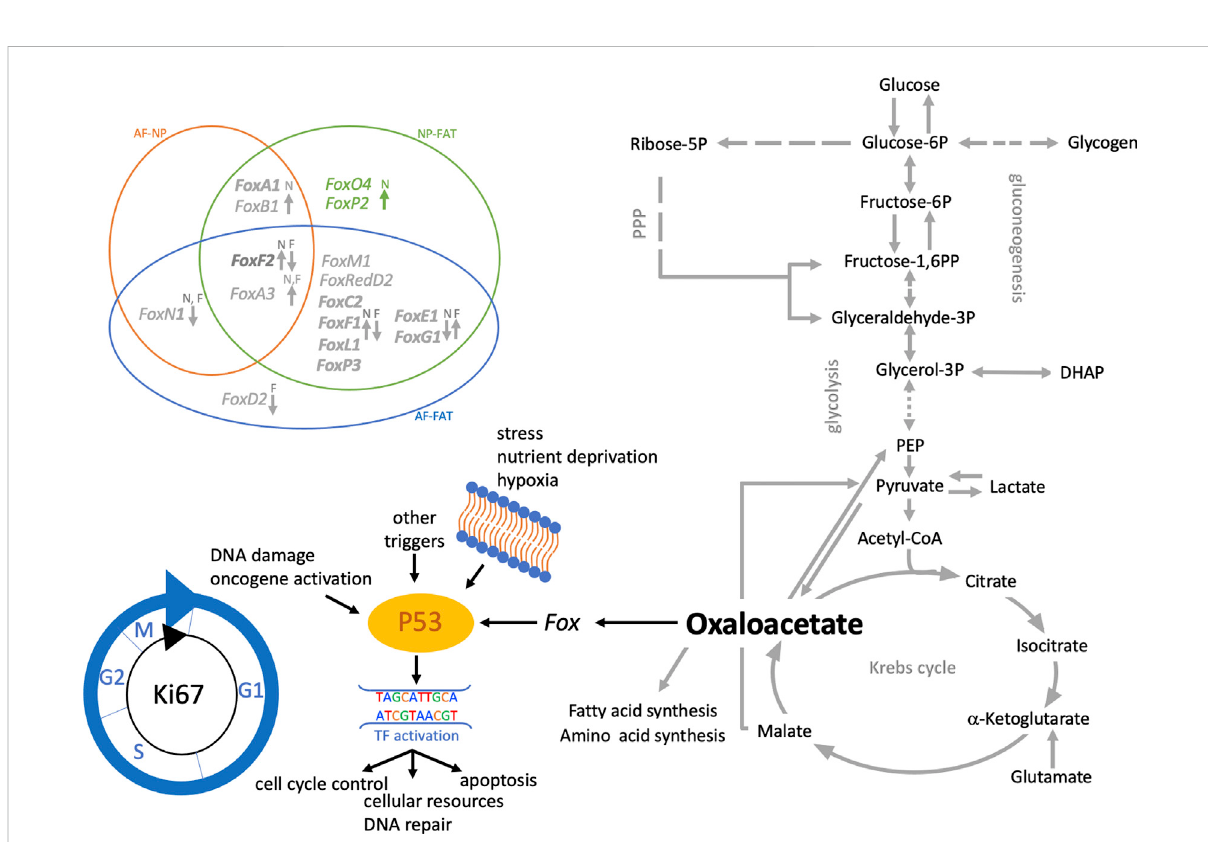
FIGURE 9 Schematic of pathways involving glucose and lactate metabolism leading to oxalacetate production, which modulates cell function through Fox transcription factors. Venn diagram shows the differentially expressed Fox genes between IVD (AF, NP) and adipose (FAT) derived cells. Those withafoldchangeof3orhigherinNPoverFAT.Arrowsindicateup-ordownregulation.ThecolorschemefollowsTable3.Cellswereisolatedfroma single donor to avoid the genotype effect. Cells were analyzed as three replicates for AF and NP and two replicates for FAT